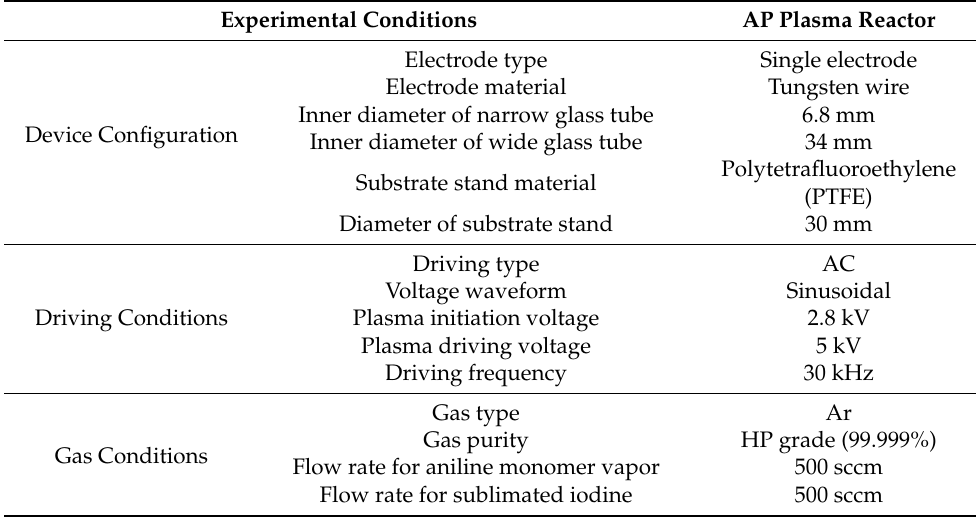
Table 1. Experimental conditions for AP plasma polymerization with in-situ I 2